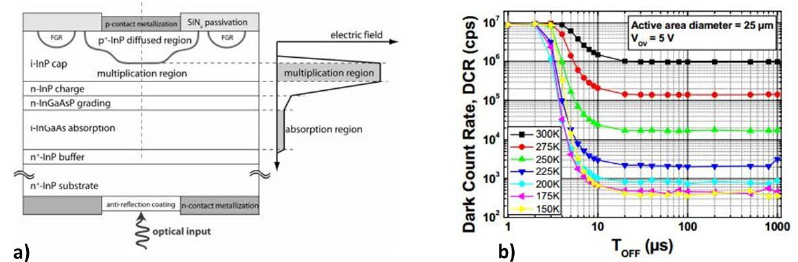
Figure 10: InGaAs/InP epitaxial structure (a) with an InGaAsP grading layer for control of the electric field profile, floating guard rings for edge breakdown control, and Zn diffused regions in the active area for a uniform gain profile. A DCR of few kHZ is obtained at 225 K in gated mode operation with a 10us hold-off time (b). From [58].